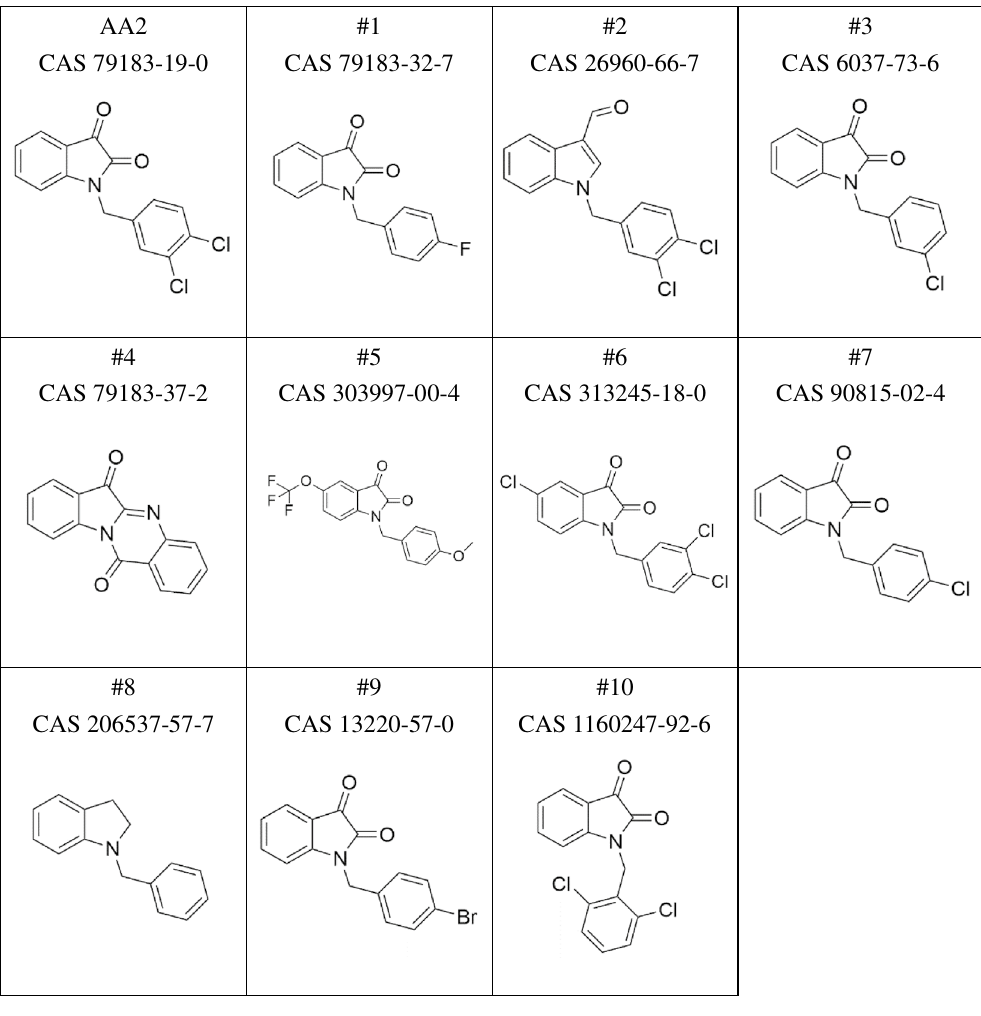
Table 2. Structure of AA2 and its